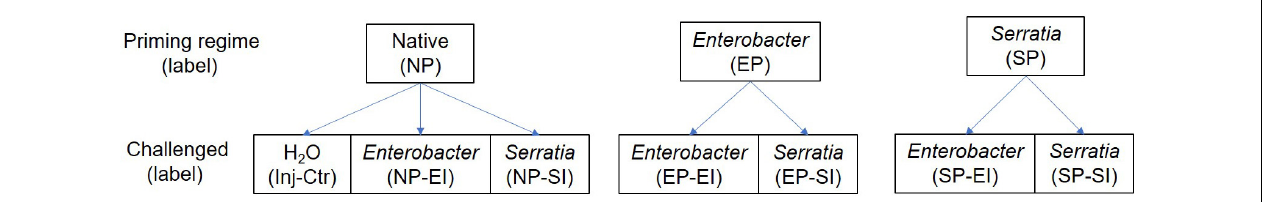
FIGURE 1 | Scheme of priming, challenge, and sampling for RNA-seq. Newly emerged An. gambiae G3 mosquitoes were set into three cohorts for priming treatment via sugar meal: native microbiota, supplemented with Enterobacter and Serratia . The primed cohorts were then subject to Enterobacter and Serratia challenge, respectively. The sterile H 2 O injection in native primed cohort was used as injury control. RNA samples were extracted from each cohort for RNA-seq, a total of 30 samples were collected from 10 conditions with three replicates for each condition.